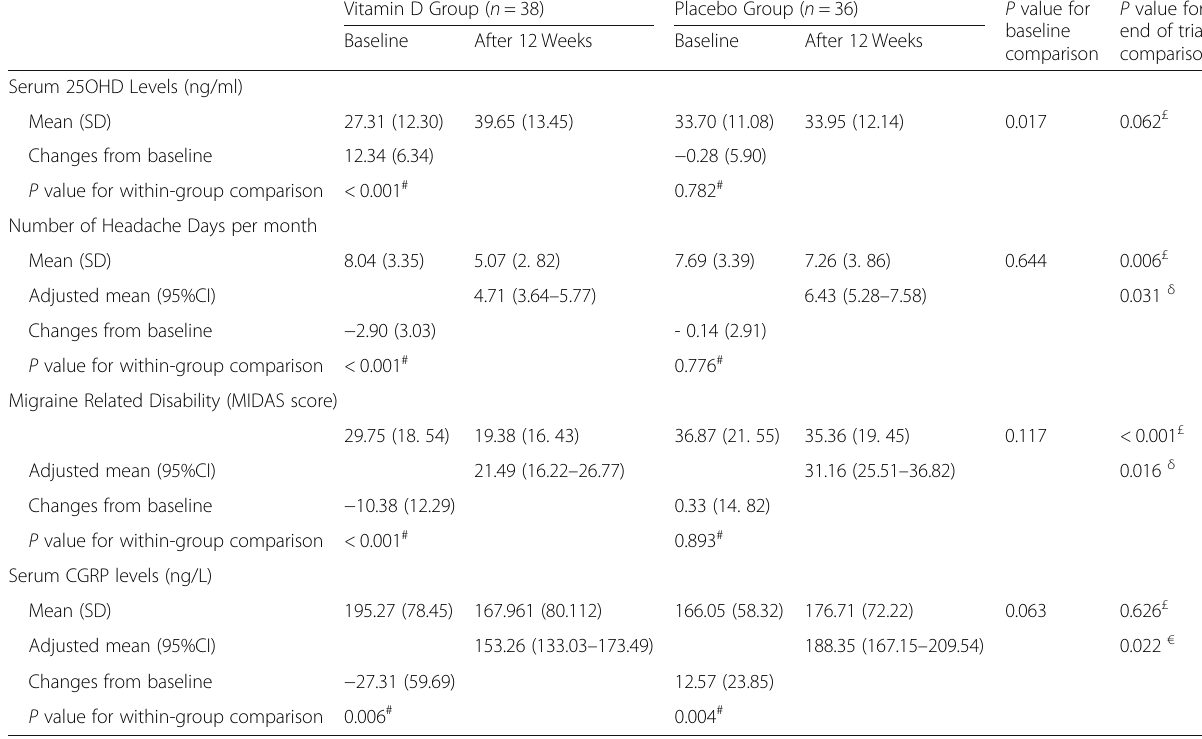
Table 2 Changes in migraine characteristics, the use of analgesics and serum CGRP levels before and after supplementation with vitamin D or placebo in episodic migraine